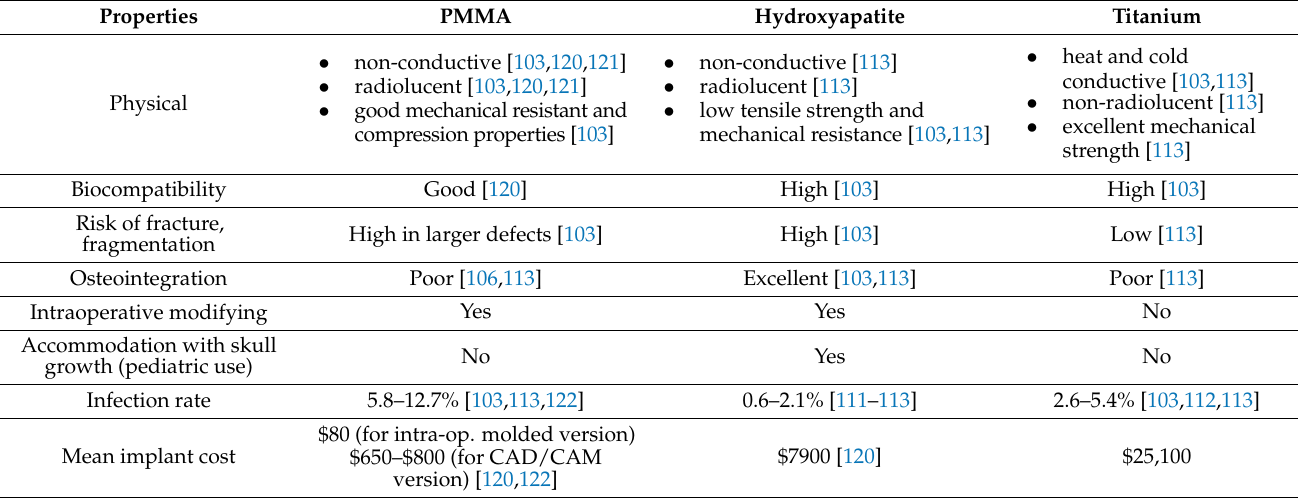
Table 2. Comparison of bone-substitute materials used for